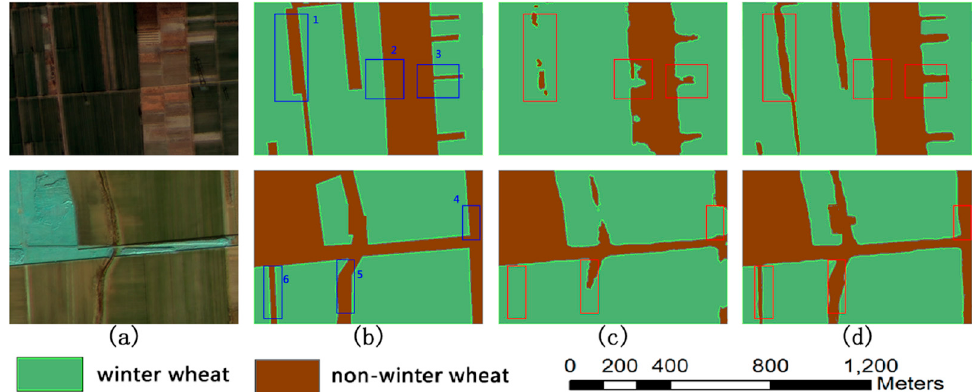
Figure 10. Segmentation errors comparison: ( a ) original images, ( b ) ground truth, ( c ) errors of RefineNet results, and ( d ) errors of CEM results.